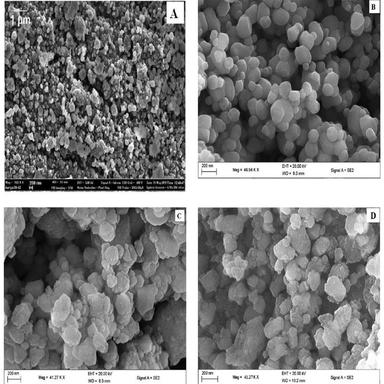
SEM micrograph for (A) eggshell powder; (B) titanium dioxide; (C) TiO2-EB before agitation; (D) TiO2-EB after agitation.